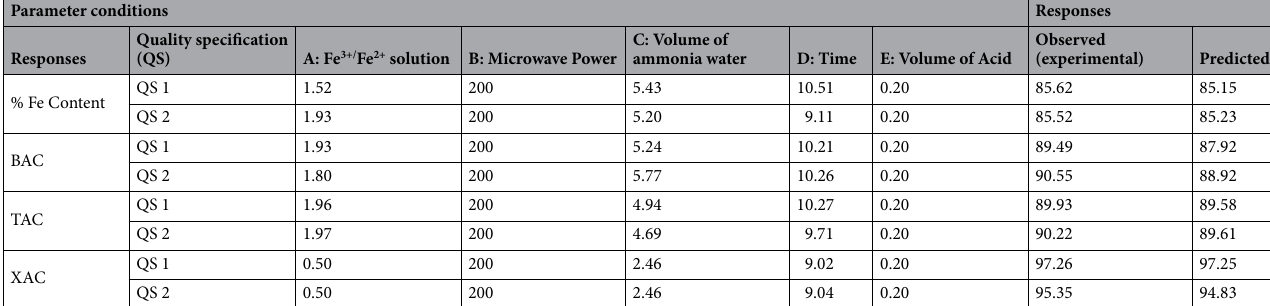
Table 3. Optimization constraints for MNP-OA composite, % Fe content and its performance on Benzene, toluene and xylene adsorption capacity.